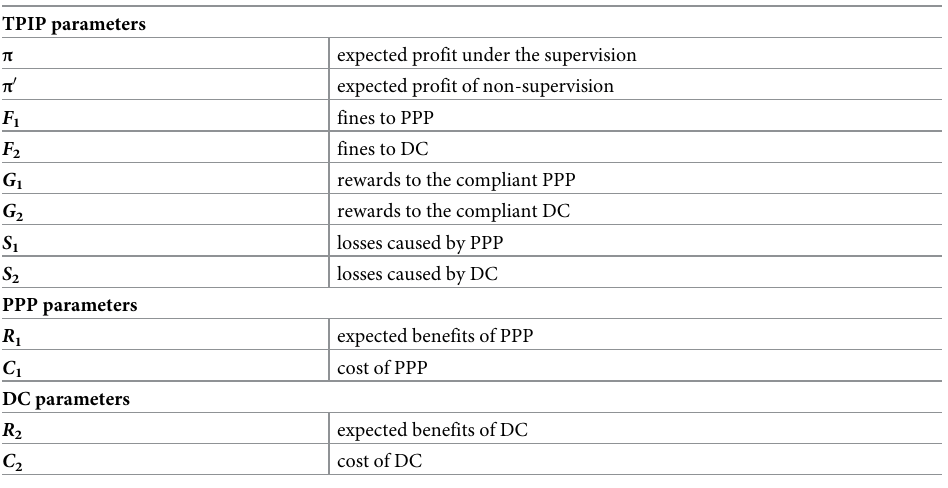
Table 1. Notation used in the models.